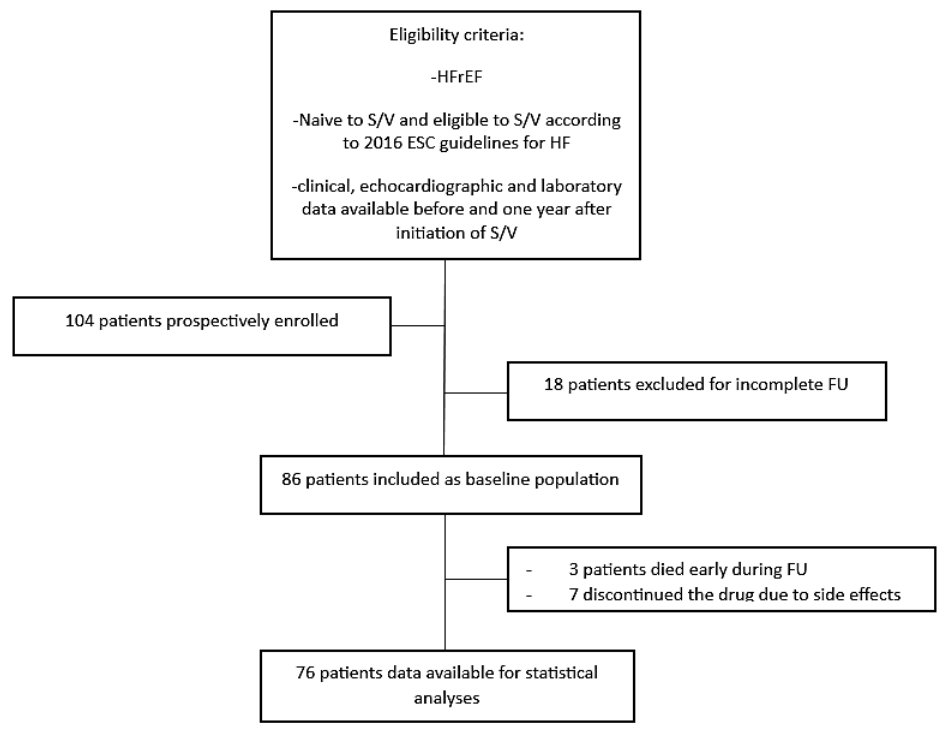
Figure 1. Study Figure 1. Study flow-chart.